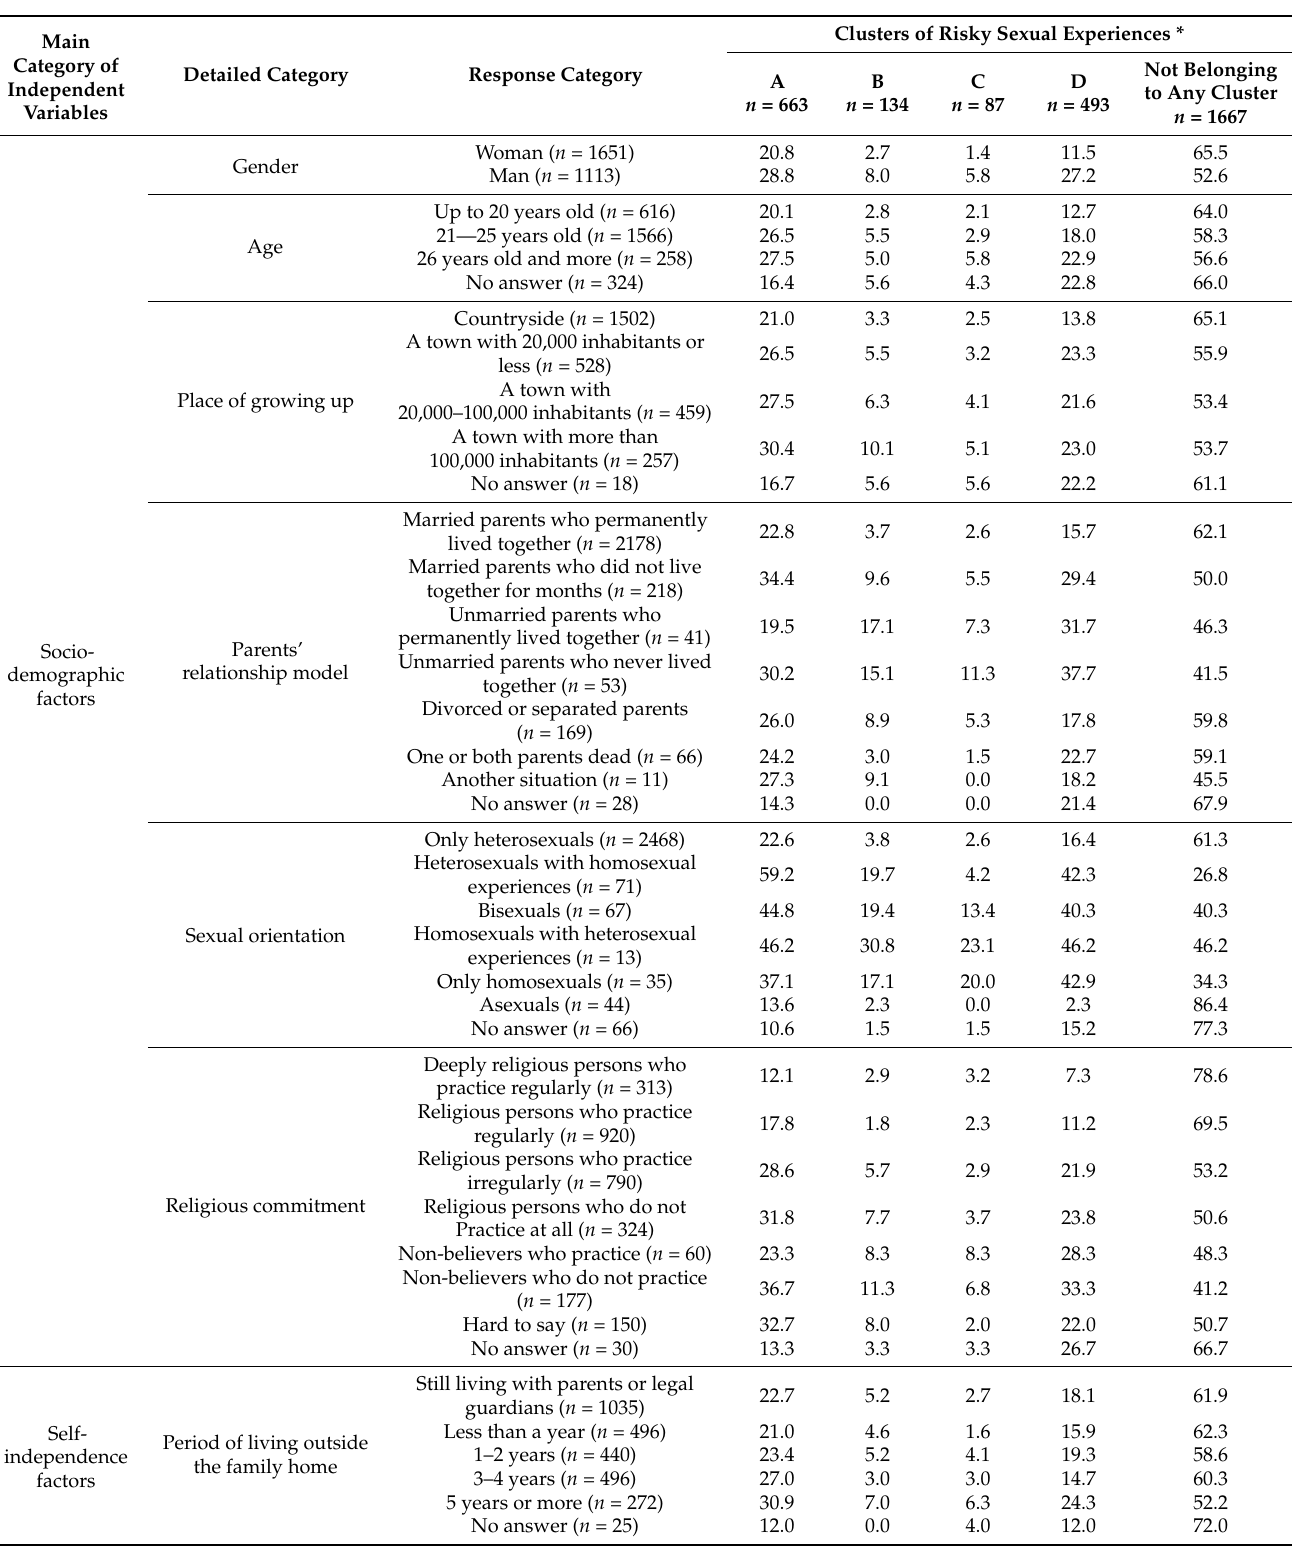
Table A2. Characteristics of the identified clusters (% out of particular response category) ( n =